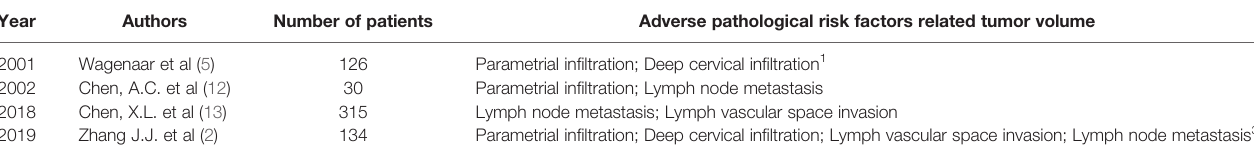
TABLE 2 | The comparison of correlation between the tumor volume and adverse pathological risk factors of the above-mentioned studies and our